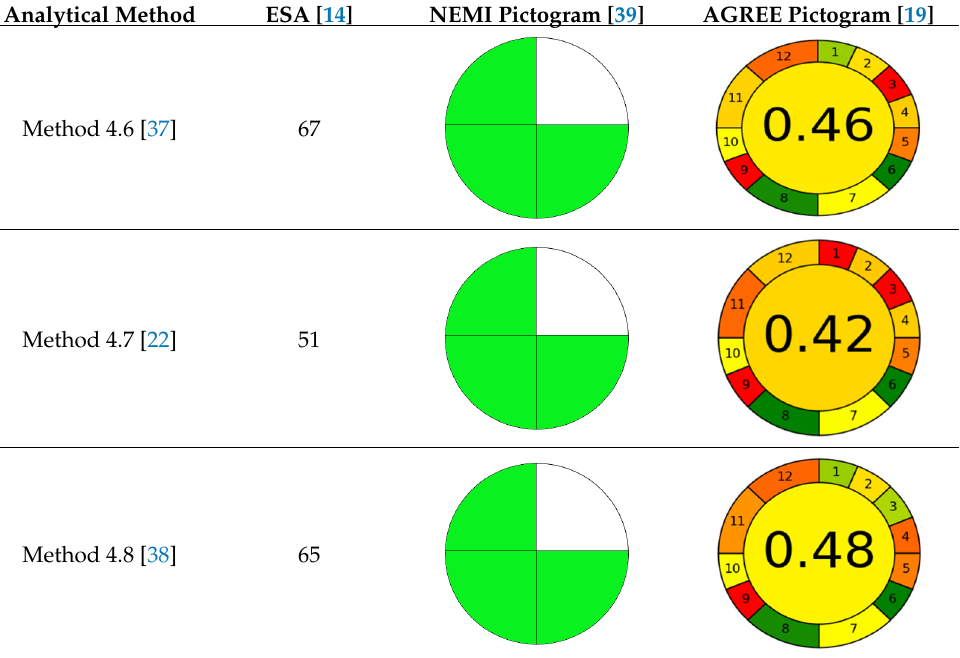
Table 4. Greenness assessment results of methamphetamine and heroin analytical procedures.